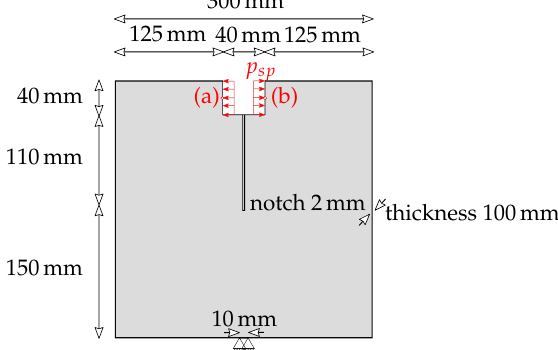
Figure 2. Geometry and boundary conditions of the numerical model of the specimen for the wedge splitting